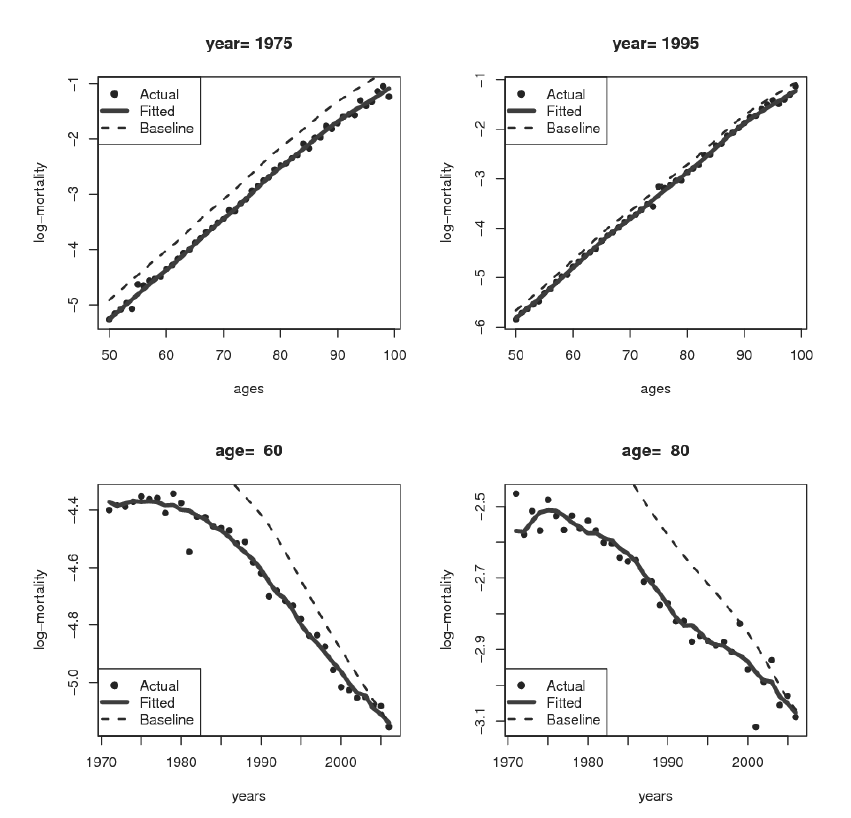
Figura 6 – Observed and fitted mortality rates for selected years and ages. Ip = H and Ic = m 0 . Italy,